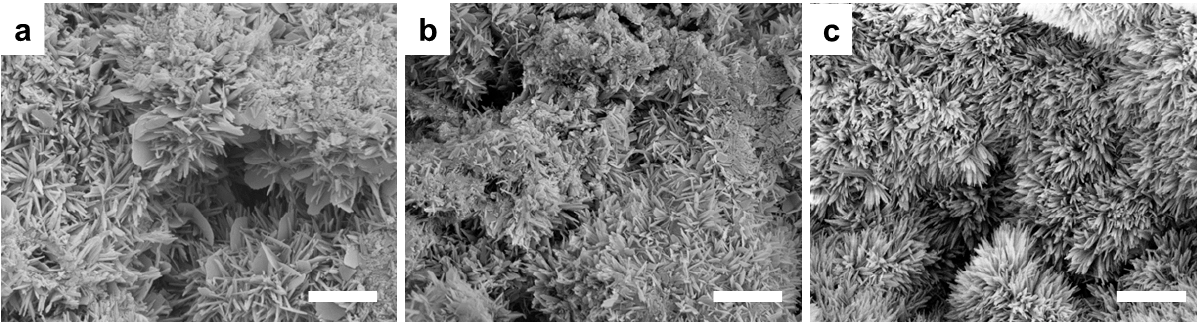
Figure 7. Morphology of the Sr2 cements obtained by powders milled with different milling media diameters: 5 ( a ), 2 ( b ), 1 mm ( c ). Scale bars: 1 µm.